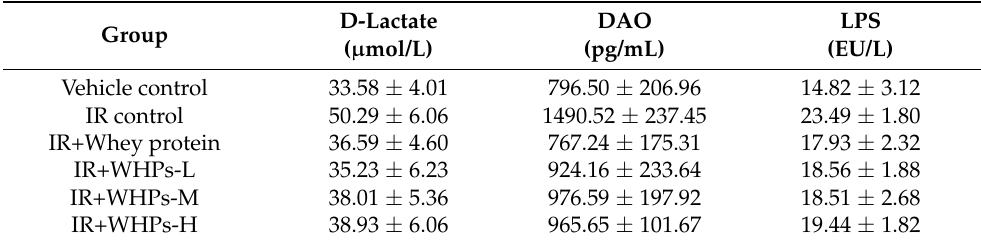
Table 12. Effect of WHPs on intestinal permeability in irradiated mice on 14th day ( n = 12, x ±